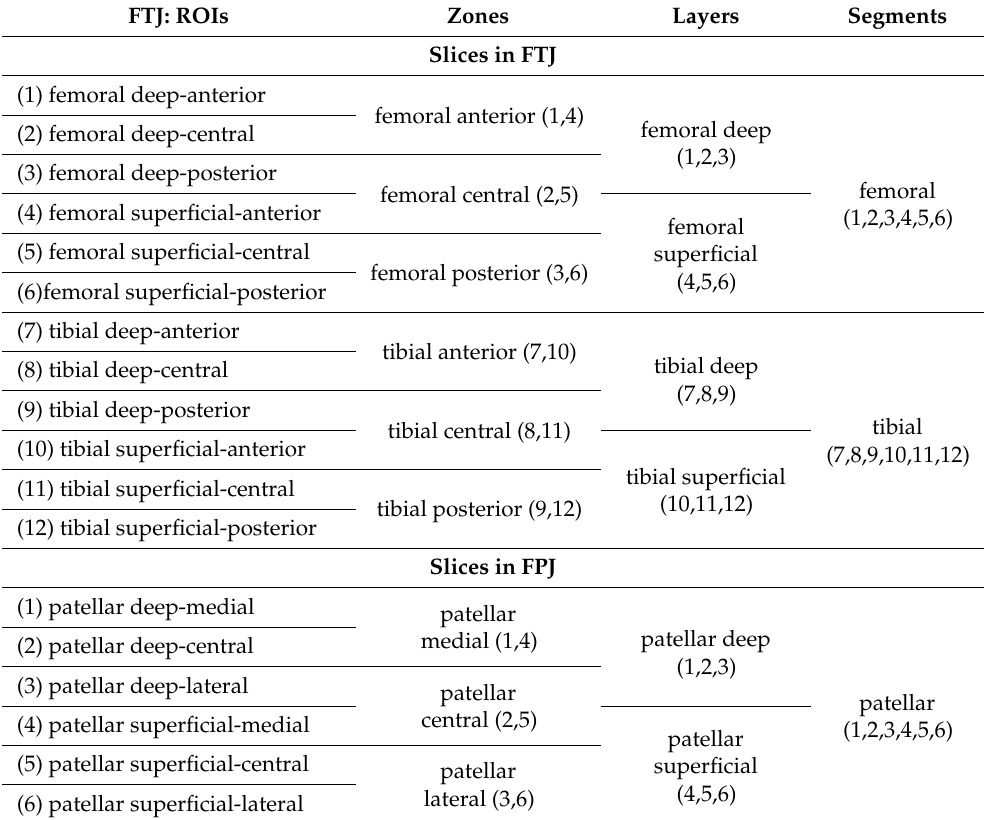
Table 2. Outline of ROIs for cartilage segments, layers, and zones in the FTJ and retropatellar. FTJ: ROIs Zones Layers Segments Slices in